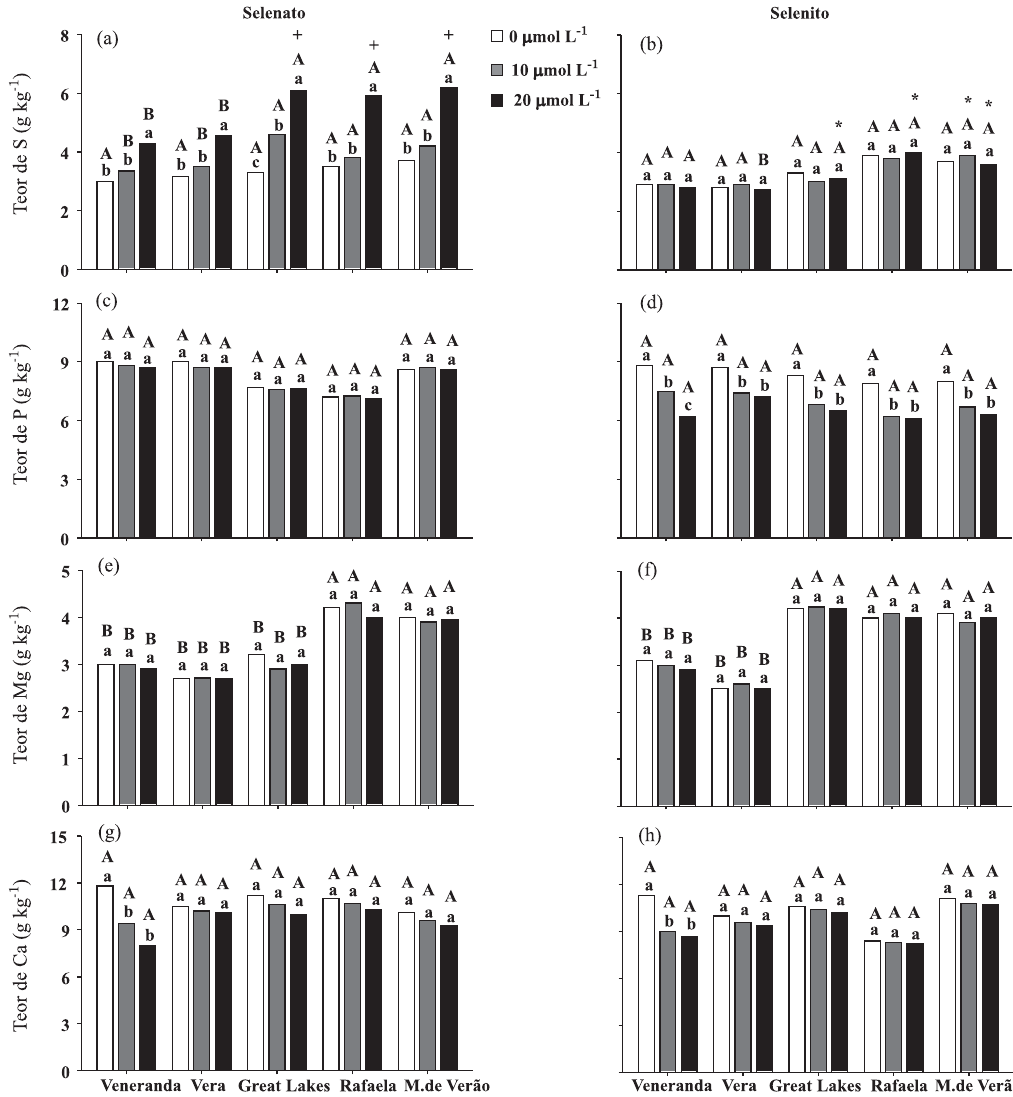
Figura 2. Teores de S (a, b), P (c, d), Mg (e, f) e Ca (g, h) na parte aérea de cultivares de alface, em função da aplicação de diferentes concentrações e formas de Se. Médias seguidas de mesma letra minúscula, comparando concentrações de Se dentro de cada cultivar, e maiúscula, comparando as cultivares em cada concentração e forma de Se, não diferem entre si (Scott-Knott, p ≤≤≤≤≤ 0,05). Médias seguidas por símbolos diferentes (+ e *), comparando as formas de Se (selenato e selenito) dentro de cada concentração de Se e cultivar, diferem entre si (Scott-Knott, p ≤≤≤≤≤